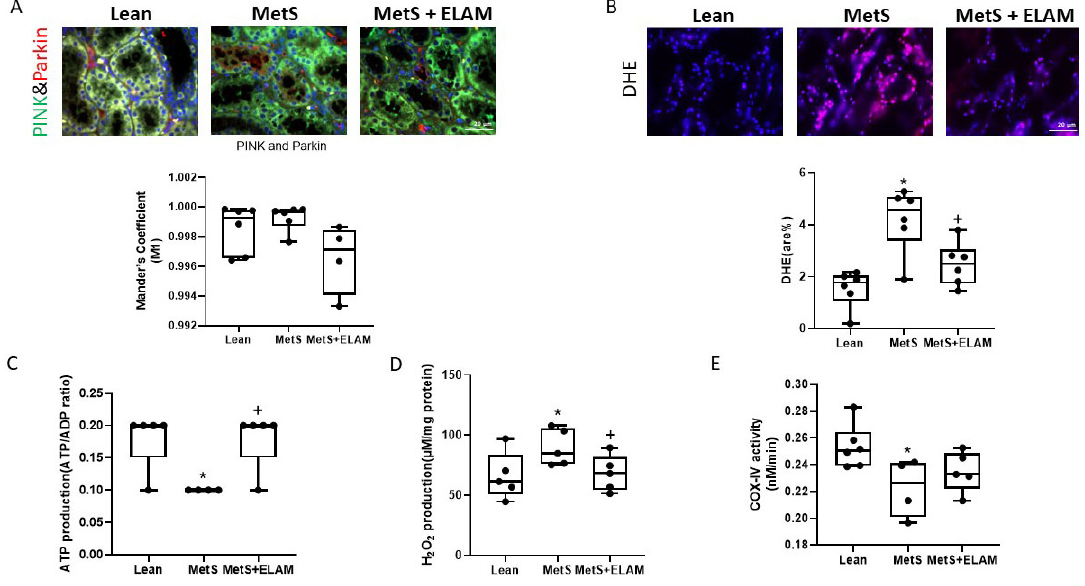
Figure 2. ELAM ameliorates mitochondrial function. ( A ) Representative renal immunofluorescence staining for PINK (green) and Parkin (red). No change in their co-localization showed no mitophagy. ( B ) Renal oxidative stress was evaluated by in situ production of superoxide anion by fluorescence microscopy using dihydroethidium (DHE), showing increased renal oxidative stress that ELAM ame- liorated. ( C – E ) Mitochondrial function in MetS kidneys. Mitochondrial ATP production (ATP/ADP ratio) decreased in MetS compared to lean kidneys and were restored in MetS + ELAM. H 2 O 2 pro- duction increased in MetS kidneys but normalized in MetS + ELAM. Compared to Lean, COX-IV activity was lower in MetS, but not in MetS + ELAM. * p < 0.05 vs. lean, + p < 0.05 vs. MetS, Scale bar = 20 µ